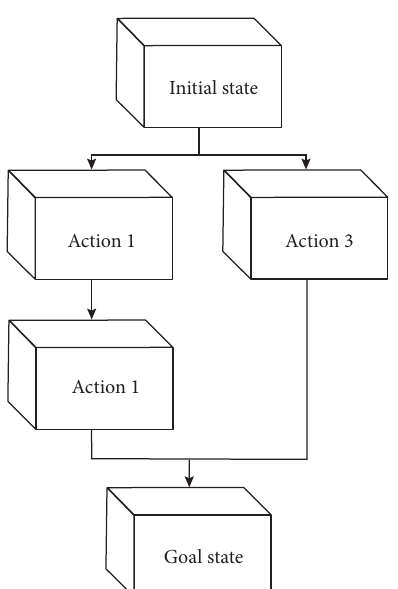
Figure 2: Classical planning problem description.